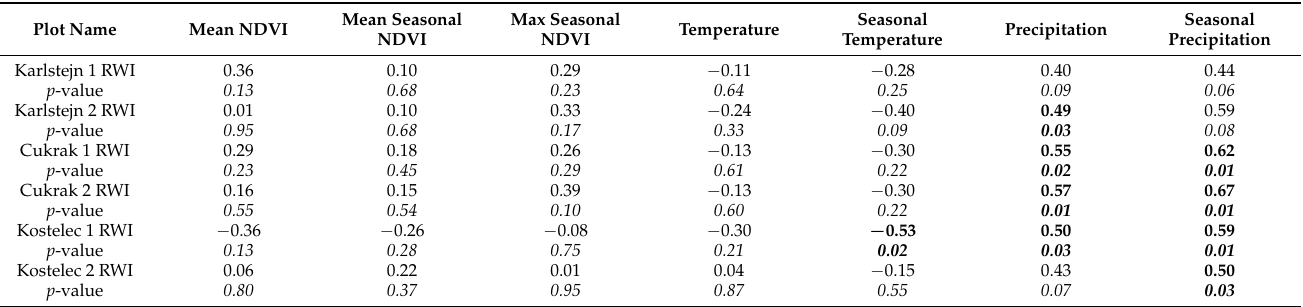
Table 3. Correlation coefficients for tree-ring width index (RWI) at research plots to NDVI, tem- perature and precipitation. Significant correlation values are in bold; correlations are significant at p <